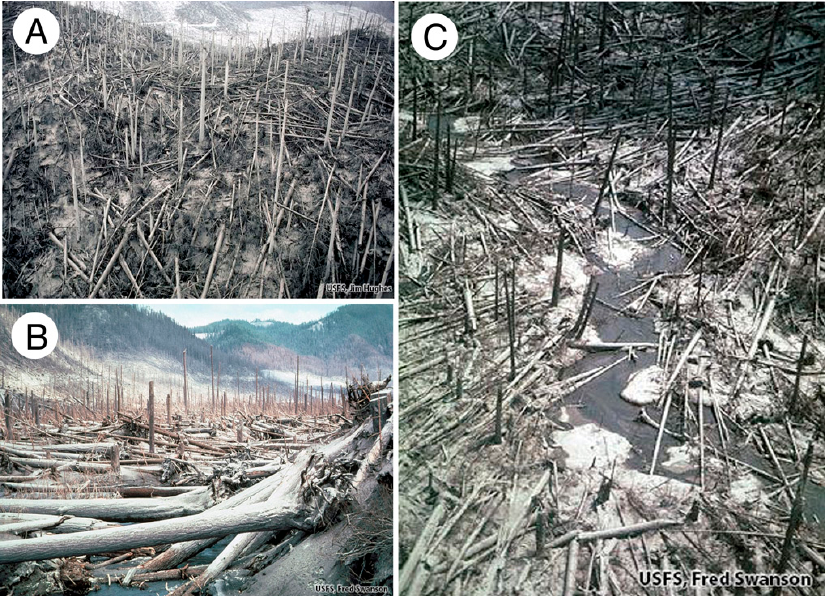
Figure 17. Destruction of trees from May 18, 1980 eruption of Mount Saint Helens (WA, USA). ( A , B ) “Blast zone” where fallen logs are oriented in the direction of wind created during explosive eruption. In more protected areas some trees were left standing, and even on fallen trees fractured limbs remained on the ash-covered ground surface; ( C ) Streams flowing down blast zone slopes transported ash, pumice, and broken limbs, but lacked sufficient energy to move fallen logs. Photos courtesy of United States Forest Service.